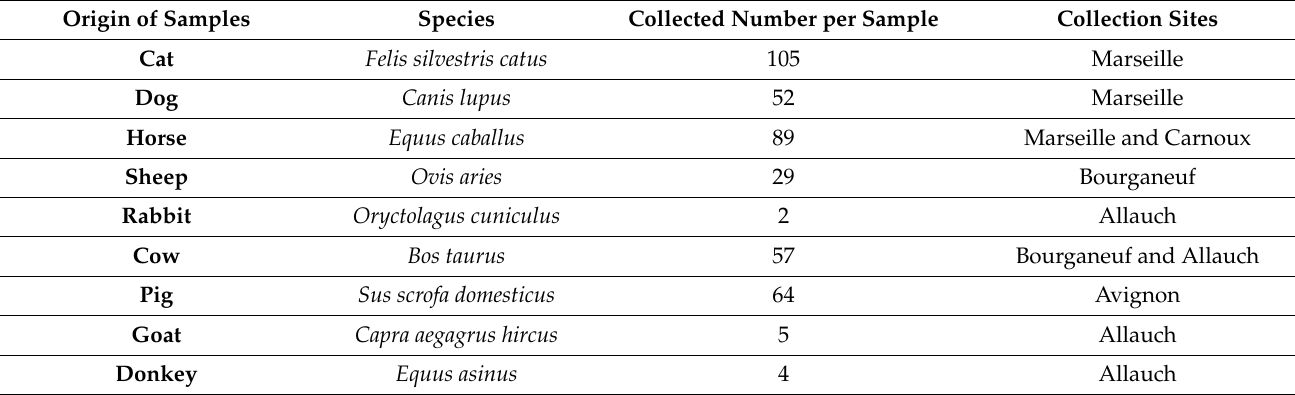
Table 2. Details of 407 feces samples here investigated for the presence of